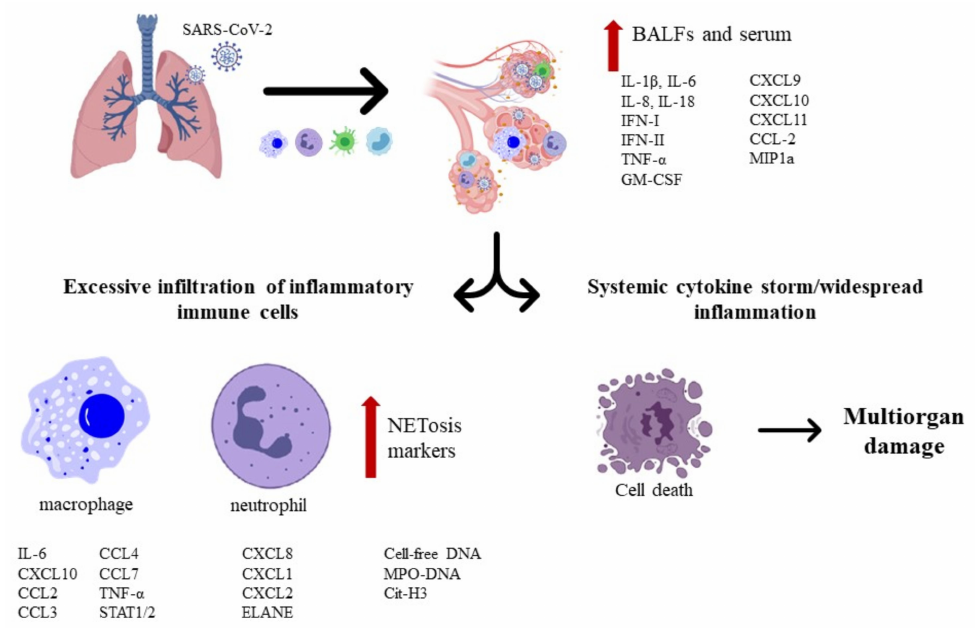
Figure 2. Overview of lung pathology in patients with severe acute respiratory syndrome coronavirus 2. The black arrows show the pathways of lung lesions after inhalation and entry of SARS-CoV-2 into the respiratory tract. The red arrows show the increase of inflammation